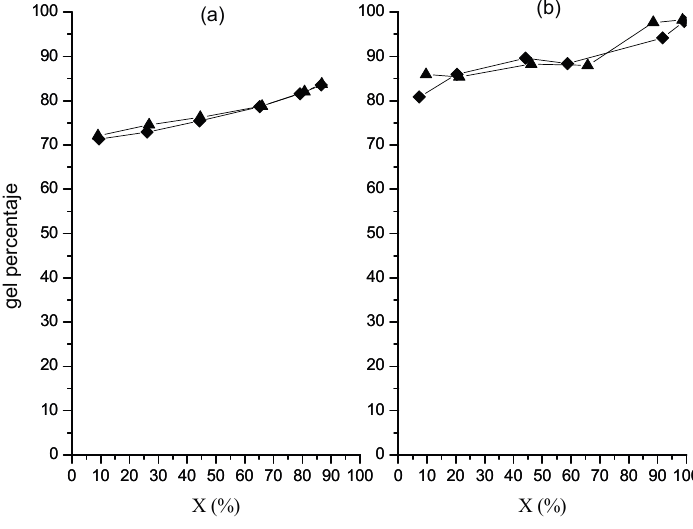
Figure 5. Variation of gel percentage in polymer in nanoparticles with global conversion from polymerizations at 0.05 ( a ) and 0.15 ( b ) g/min in organic phase dosing rate. Runs M ( ♦ ); runs MR ( ▲